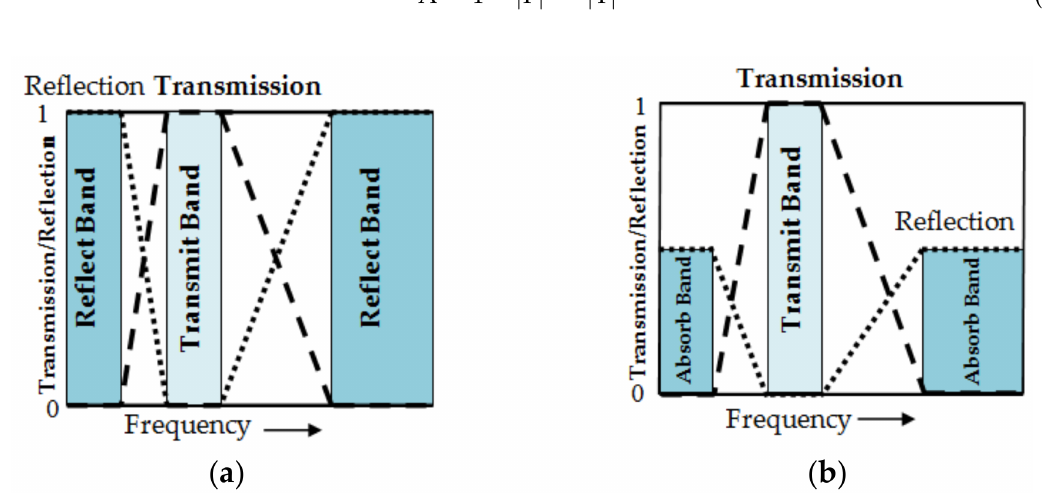
Figure 14. ( a ) FSS with good reflection characteristics ( b ) FSS with absorber